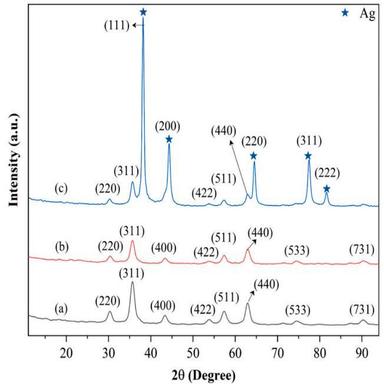
XRD patterns of (a): Fe3O4, (b): Fe3O4/QSM, and (c): Fe3O4/QSM/Ag.